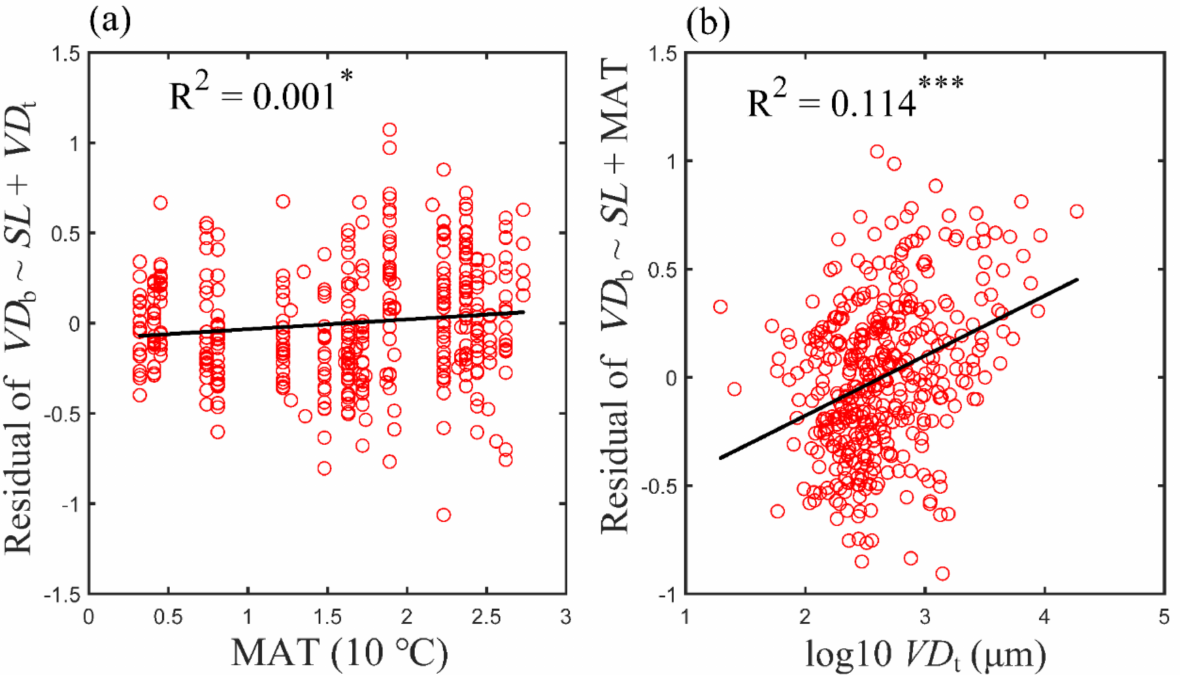
Figure 3. Relationship between residual variation in VD b and MAT ( a ) and VD t ( b ): ( a ) after eliminating the contribution of SL and VD t ; ( b ) after eliminating the contribution of SL and MAT. R 2 is indicated in each panel. Asterisks indicate levels of significance (* p < 0.05; *** p < 0.001). Abbreviations for traits and environmental variables are the same as in Table